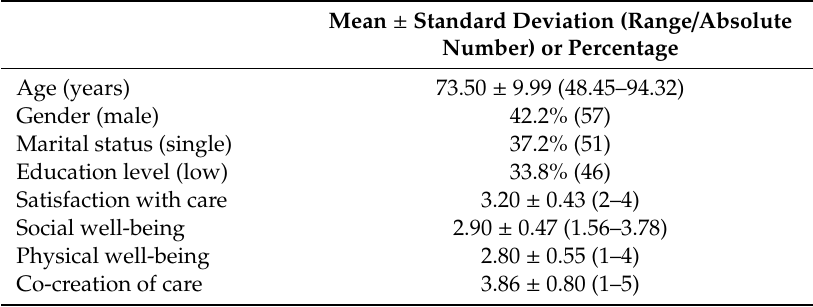
Table 1. Descriptive statistics at T1.